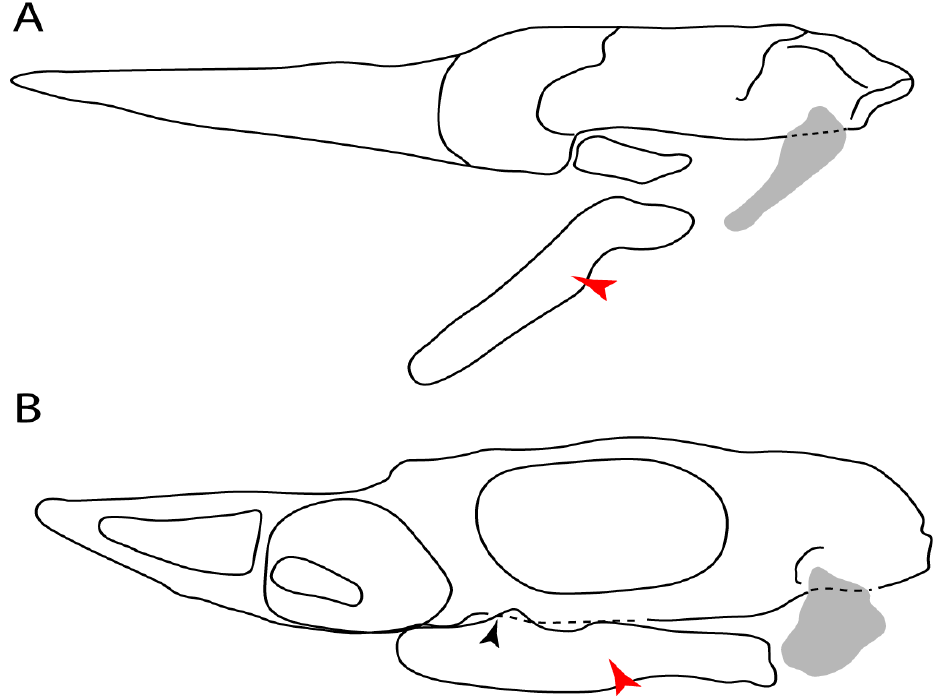
Figure 21. Interpretative drawings of the neurocranium of selected neoselachians in lateral view. State (0): ( A ) Raja sp. based on Maisey Text-Figure 6 in [92]. State (1). ( B ) Mustelus manazo (https: //sharksrays.org/ (accessed on 26 May 2020)). Red arrowheads indicate the palatoquadrate; black arrowhead indicates the ethmoidal articulation. Hyomandibula in gray